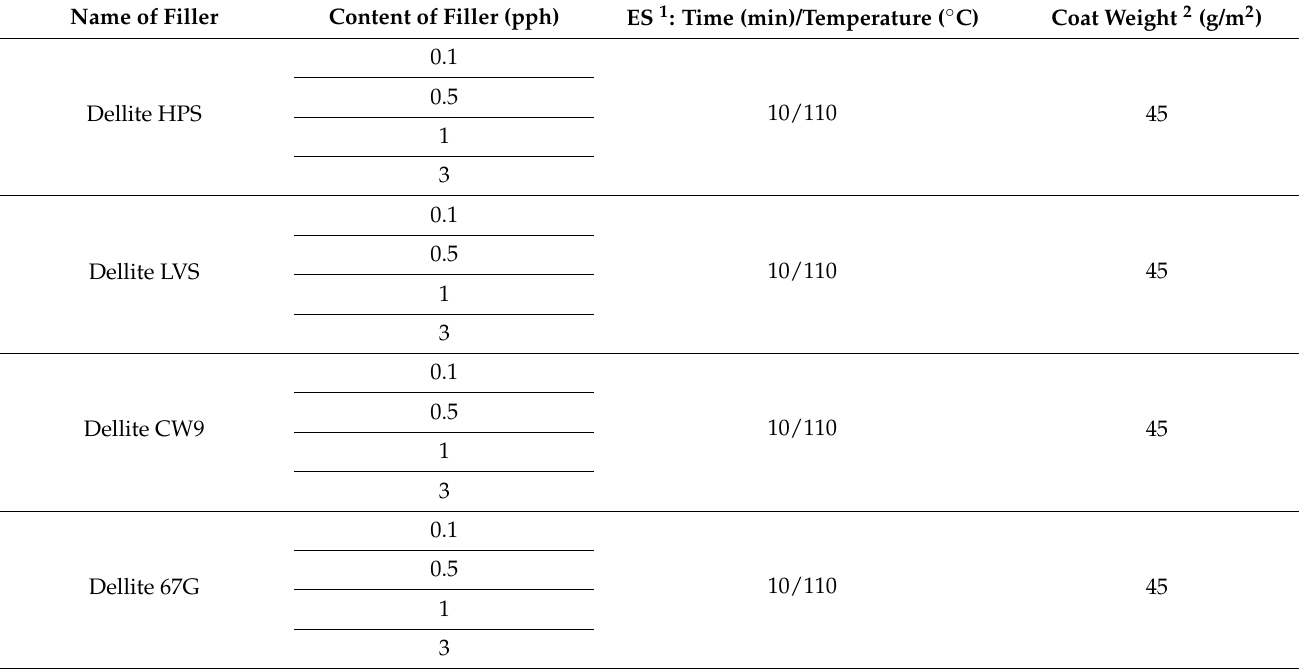
Table 2. The conditions of preparation of adhesives and adhesive